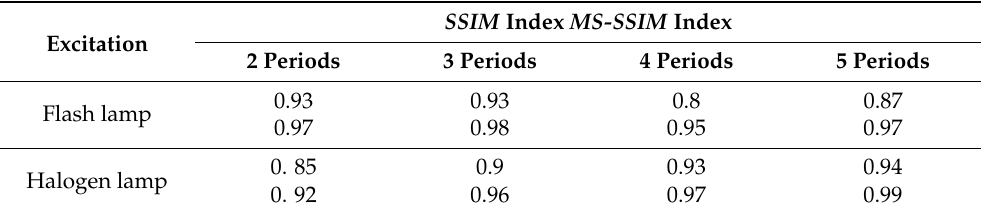
Figure 12. Phase images for the samples with the square cross section defects. A fl ash lamp was used as a source of excitation. Defects were placed 0.5 mm under the measured surface. Table 5. Comparation of phase images for measurement in the case of the halogen lamp and the fl ash lamp as source of excitation for defects place 0.5 mm under measured surface.